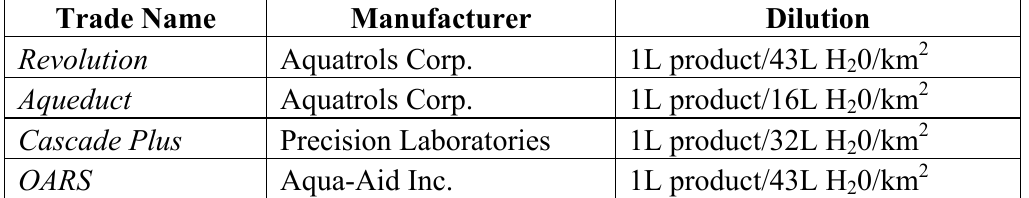
Table 1. Field application rates for surfactant products used in laboratory